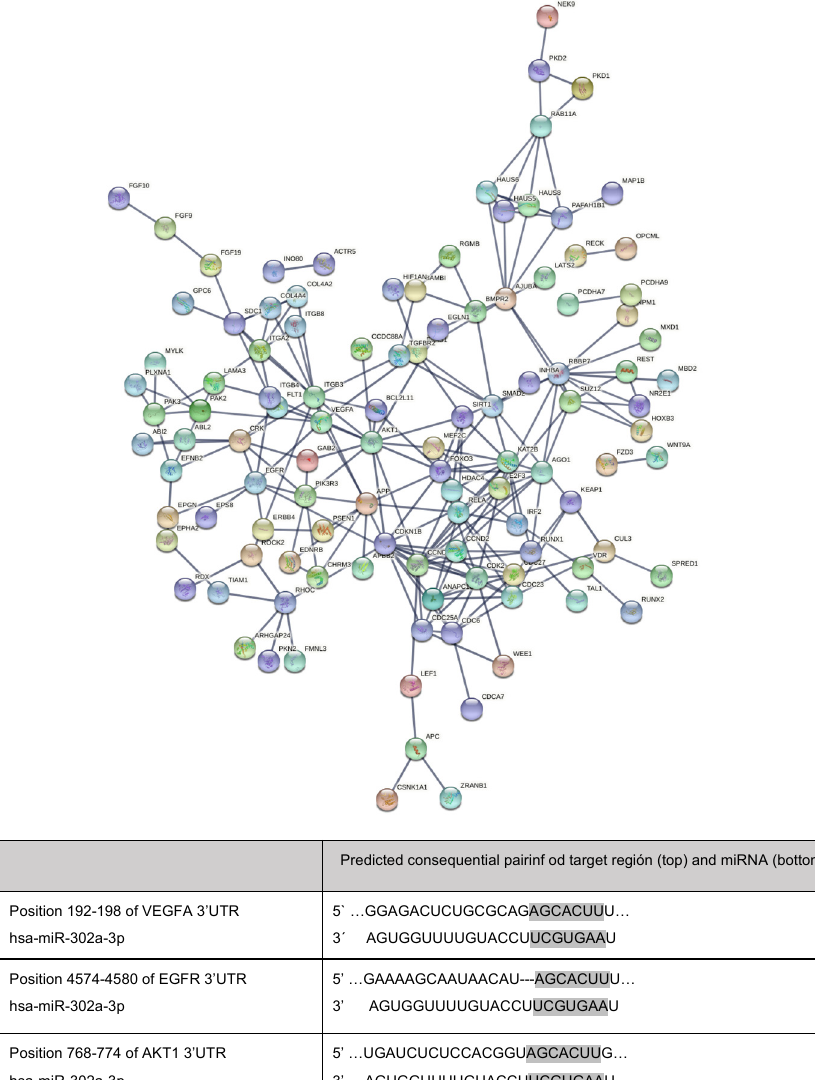
Figure 4. Angiogenic or vasculogenic pathways regulated by miR-302a-3p mRNA-related targets. Interactional network of miR-302a-3p angiogenic related targets, showing the connected ones ( A ). Predicted binding site of miR-302a-3p with the 3’UTR mRNA of VEGFA, EGFR, and AKT1 ( B ). 3.3. VEGFA mRNA and Angiogenesis Were Regulated by H 2 O 2 and